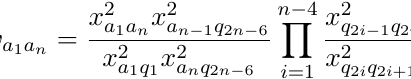
( x ) O ( x ) ∼ O σ 3 a 3 σ 4 a 4